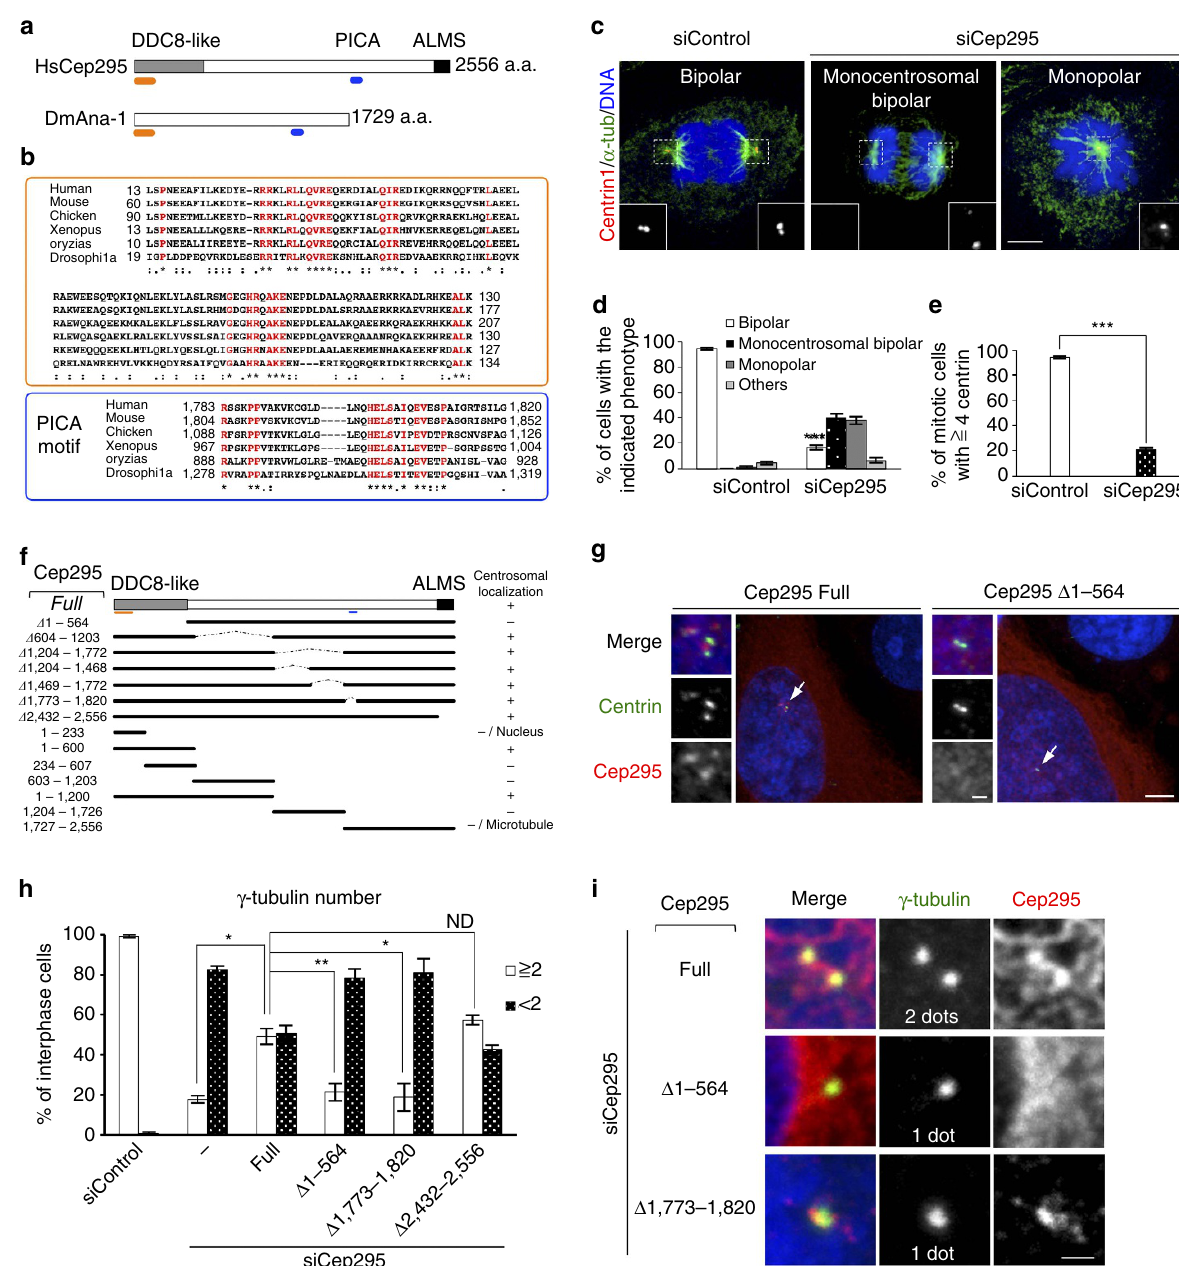
Figure 1 | Cep295 was identified as an evolutionarily conserved protein required for centriole formation. ( a ) Schematic diagrams for Human Cep295 (HsCep295) and Drosophila Ana-1 (DmAna-1). The DDC8-like domain is shown in grey box, the ALMS domain in black box. The positions of two evolutionarily conserved domains are indicated in orange and blue lines, respectively. ( b ) Alignments of the evolutionarily conserved domains within human, mouse, chicken, Xenopus and Orizias Cep295 and Drosophila Ana1. The orange and blue boxes indicate the conserved region within the DDC8-like domain and PICA (Present in C-terminal of Ana-1) motif, respectively. Identical residues determined by Cluster W2 are shown in red. Asterisks indicate the residues identical in all aligned sequences; colons: conserved substitutions; periods: semi-conserved substitutions. ( c – e ) Cep295 ensures proper mitotic spindle and centriole formation. Cep295-depleted HeLa cells were stained with the indicated antibodies. Nuclei are shown in blue. Insets show approximately two-fold magnified views around the centrosome. Scale bar, 5 m m. Histograms represent frequency of mitotic cells with the indicated phenotype ( d ) or with Z 4 centrin foci ( e ). Values are mean percentages ± standard error of the mean (s.e.m) from three independent experiments ( N ¼ 30 for each condition). *** P o 0.001 (two-tailed t -test). ( f , g ) Schematic of full-length Cep295 and the deletion constructs used for immunofluorescence assay in HeLa cells in ( f ). All constructs encode siRNA-resistant forms of Cep295. The table shows presence ( þ ) or absence ( (cid:2) ) of centriolar localization of the deletion mutant proteins examined in the cells depleted of endogenous Cep295. In ( g ), DDC8-like domain (aa 1–564) is required for centriolar localization of Cep295. The cells were stained with the indicated antibodies. Nuclei are shown in blue. Arrows point to the centrioles. Scale bars, 5 m m in the low-magnified view, 1 m m in the inset. ( h , i ) For rescue experiments, Cep295-depleted HeLa cells were transfected with full-length Cep295 and the indicated mutants. The cells were stained with the indicated antibodies. Nuclei are shown in blue. Scale bar, 1 m m. Histograms represent frequency of interphase cells with the indicated number of g -tubulin foci in each condition. Values are mean percentages ± s.e.m from three independent experiments ( N 4 50 for each condition). ** P o 0.01; * P o 0.05; NS, not significant (two-tailed t